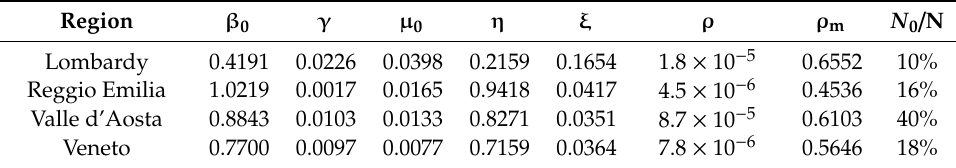
Table 1. Summary of the identified model parameters.